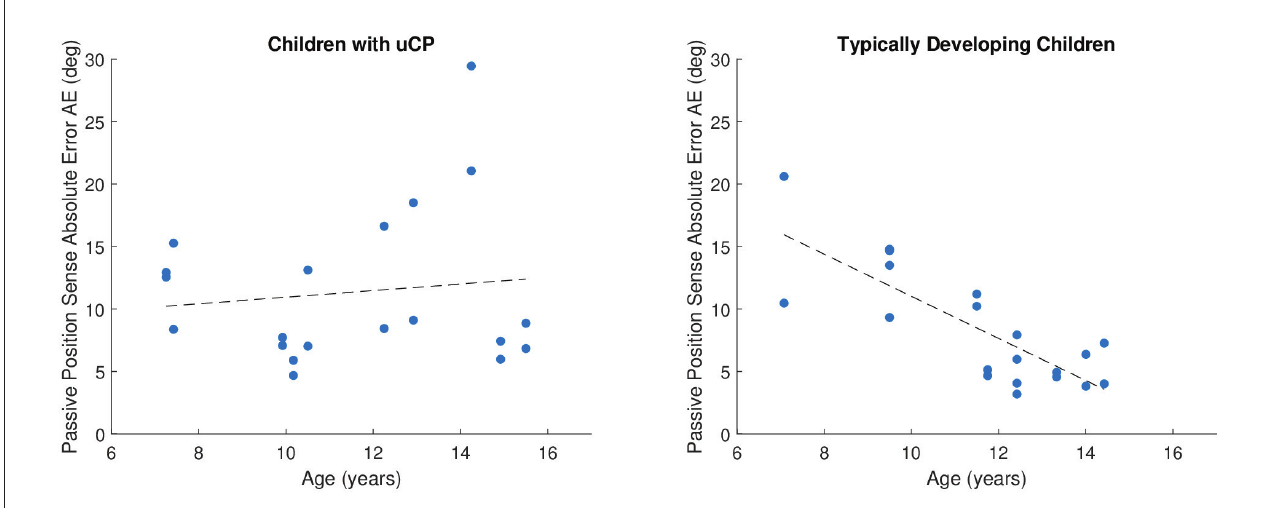
FIGURE 7 | Visualization of the effect of age on passive position sense. A clear trend and a statistically significant effect of age on passive position sense was found in TDC ( N = 20) but not in children with uCP ( N = 20) children. Data from both hands are considered together in the figure. Younger TDC tended to have higher passive position sense errors than older ones, which means that proprioceptive performance increased with age. The lower the Absolute Error the better.